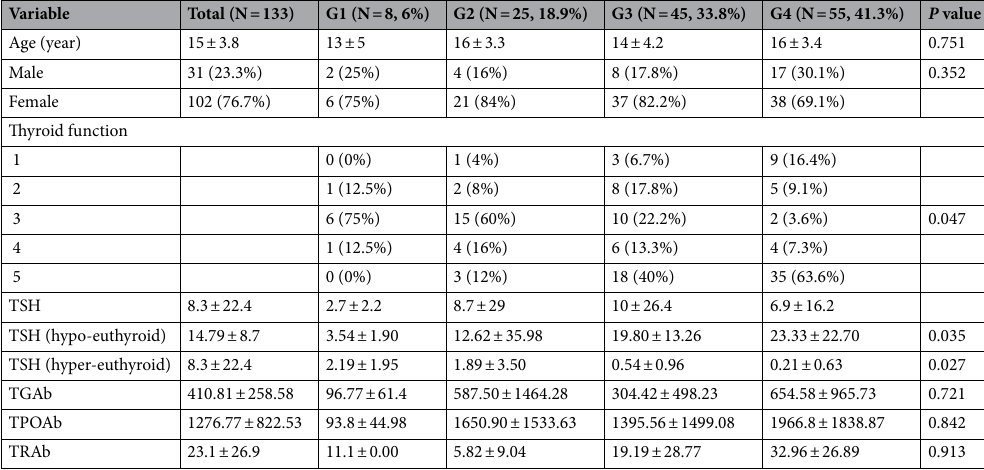
Table 1. Clinical characteristics according to ultrasound grade. G, grade; N, number of patients; TSH, thyroid stimulating hormone; TG, antithyroglobulin antibodies; TPO, antithyroid peroxidase antibodies; TRAb, TSH receptor